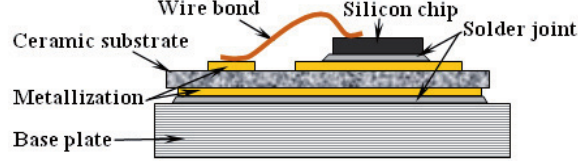
Fig. 1. Structure of a wire bonding IGBT